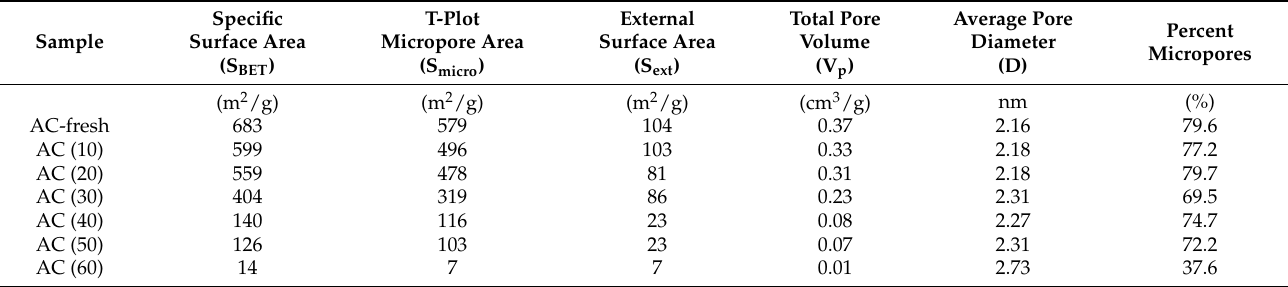
Table 3. Surface properties of fresh and functionalized activated carbon.